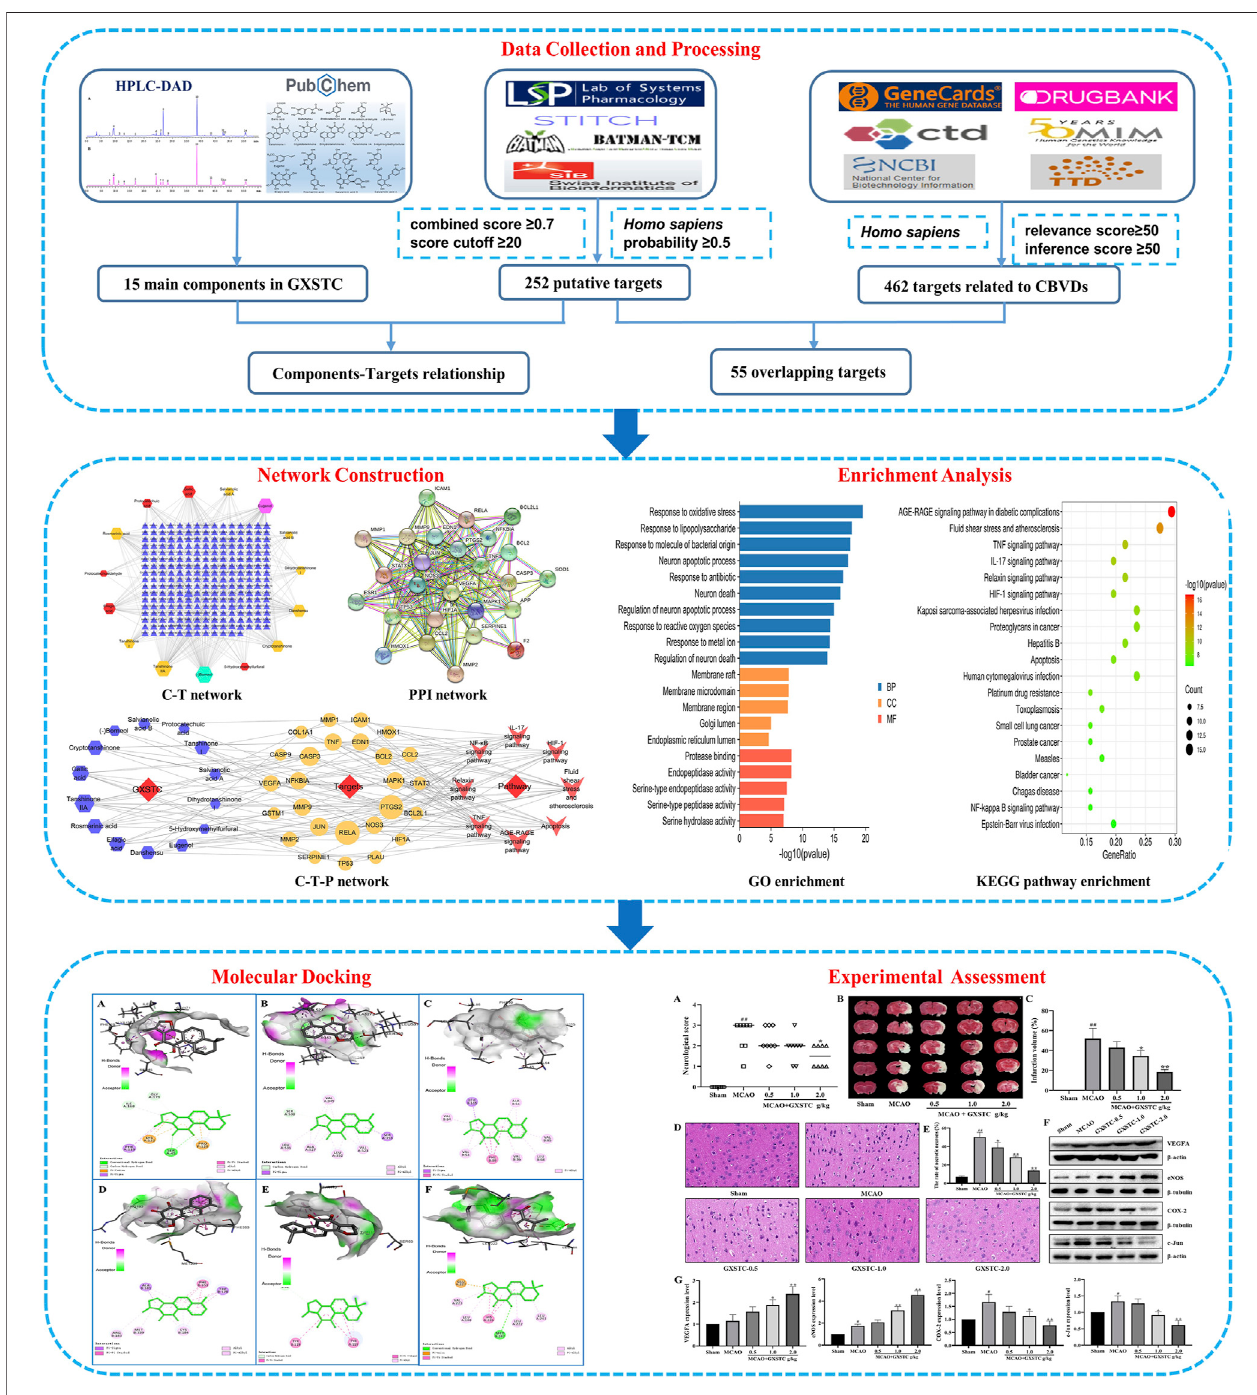
FIGURE 1 | Work fl ow of systems pharmacology analysis and experimental assessment.